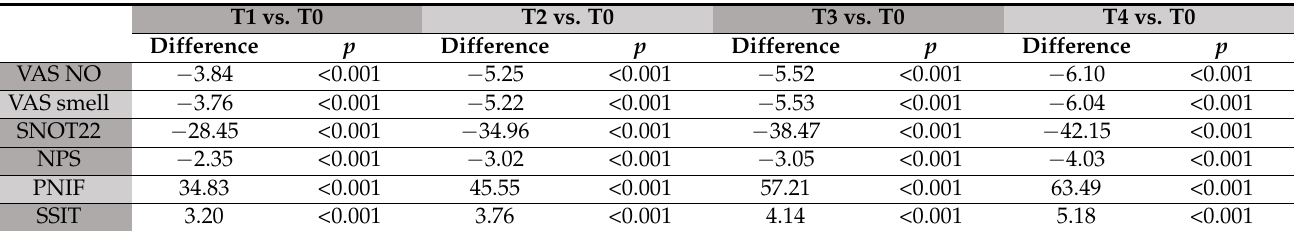
Table 2. Patients’ clinical changes during the